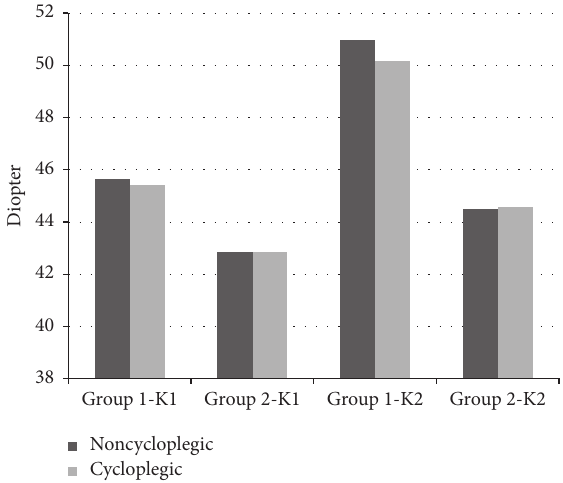
Figure 1: Keratometric changes with cycloplegia. K1: flat meridian of the anterior corneal surface, K2: steep meridian of the anterior corneal